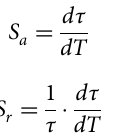
We have measured the temperature-dependent decay curves of Sc 2 (MoO 4 ) 3 :Yb/1%Er phosphors with different Yb 3 + concentra- tions (10%, 20%, and 25%). Accordingly, Sc 2 (MoO 4 ) 3 :20%Yb/1% Er phosphors exhibited the optimal S a of 53.0 μ sK − 1 and S r of 12.3% K − 1 (Supplementary Fig. 14 and Table 1). Temperature-